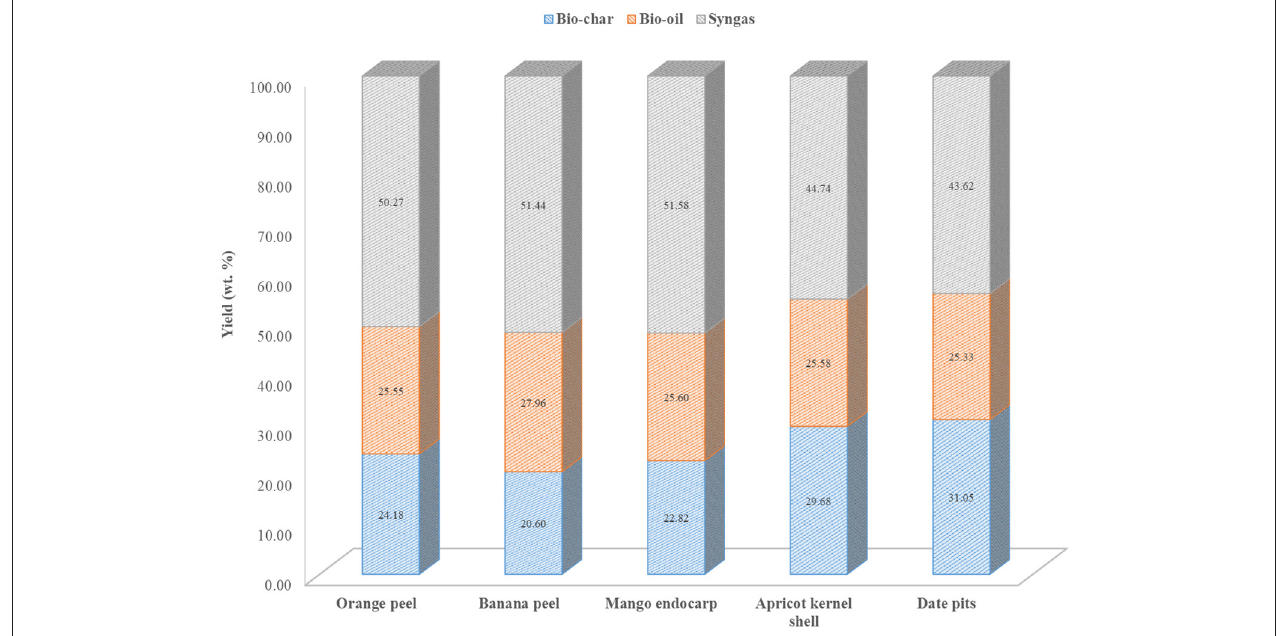
FIGURE 2 | Product yield of the selected fruit